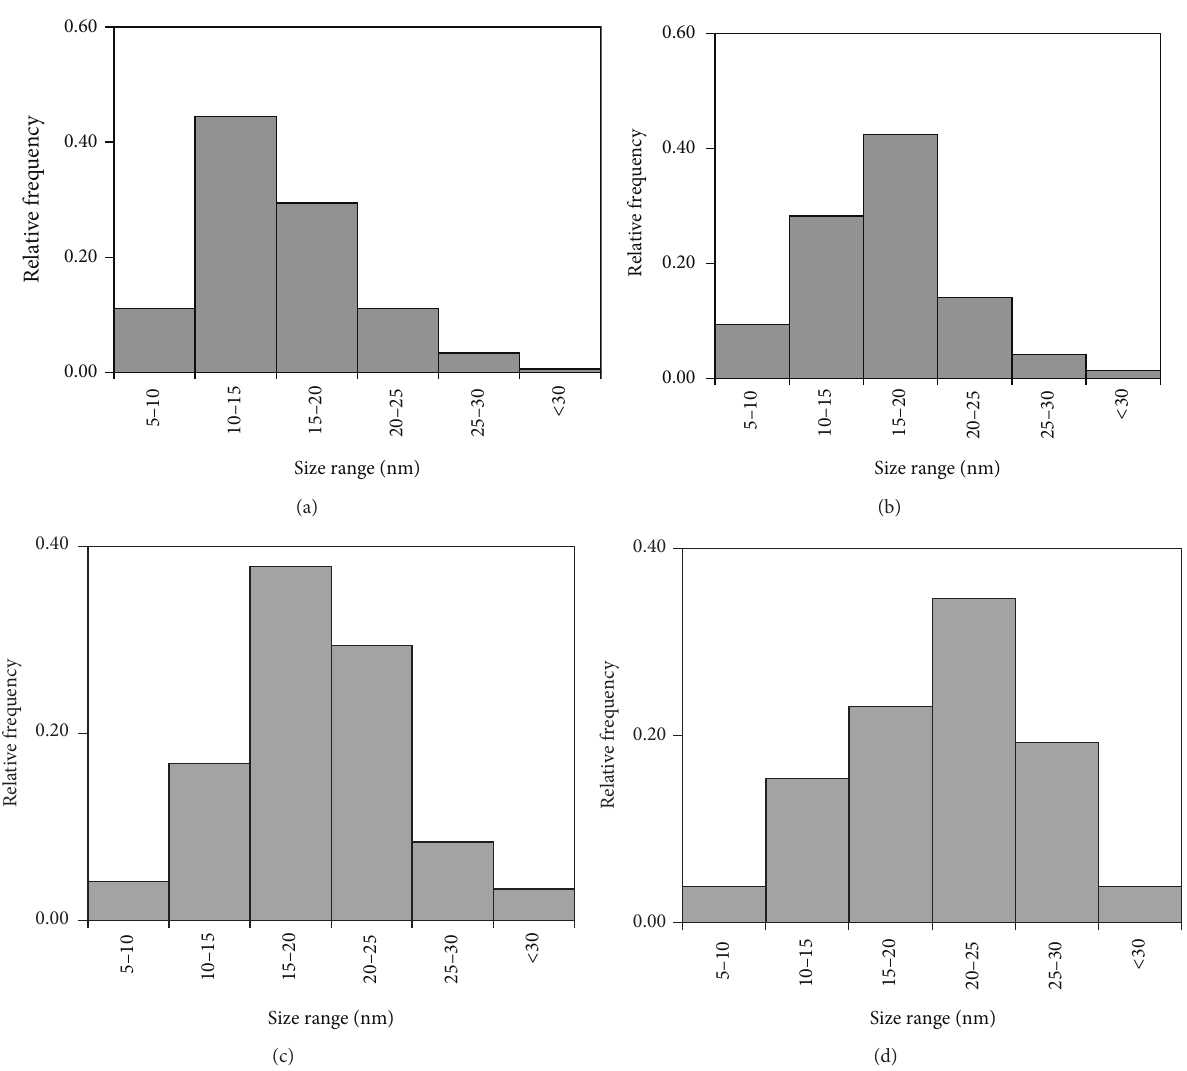
Figure 5: Relative particle size distribution of prepared catalysts after calcinations ((a) HLB = 13.9, (b) HLB = 23.7, (c) HLB = 31.2, (d) HLB =